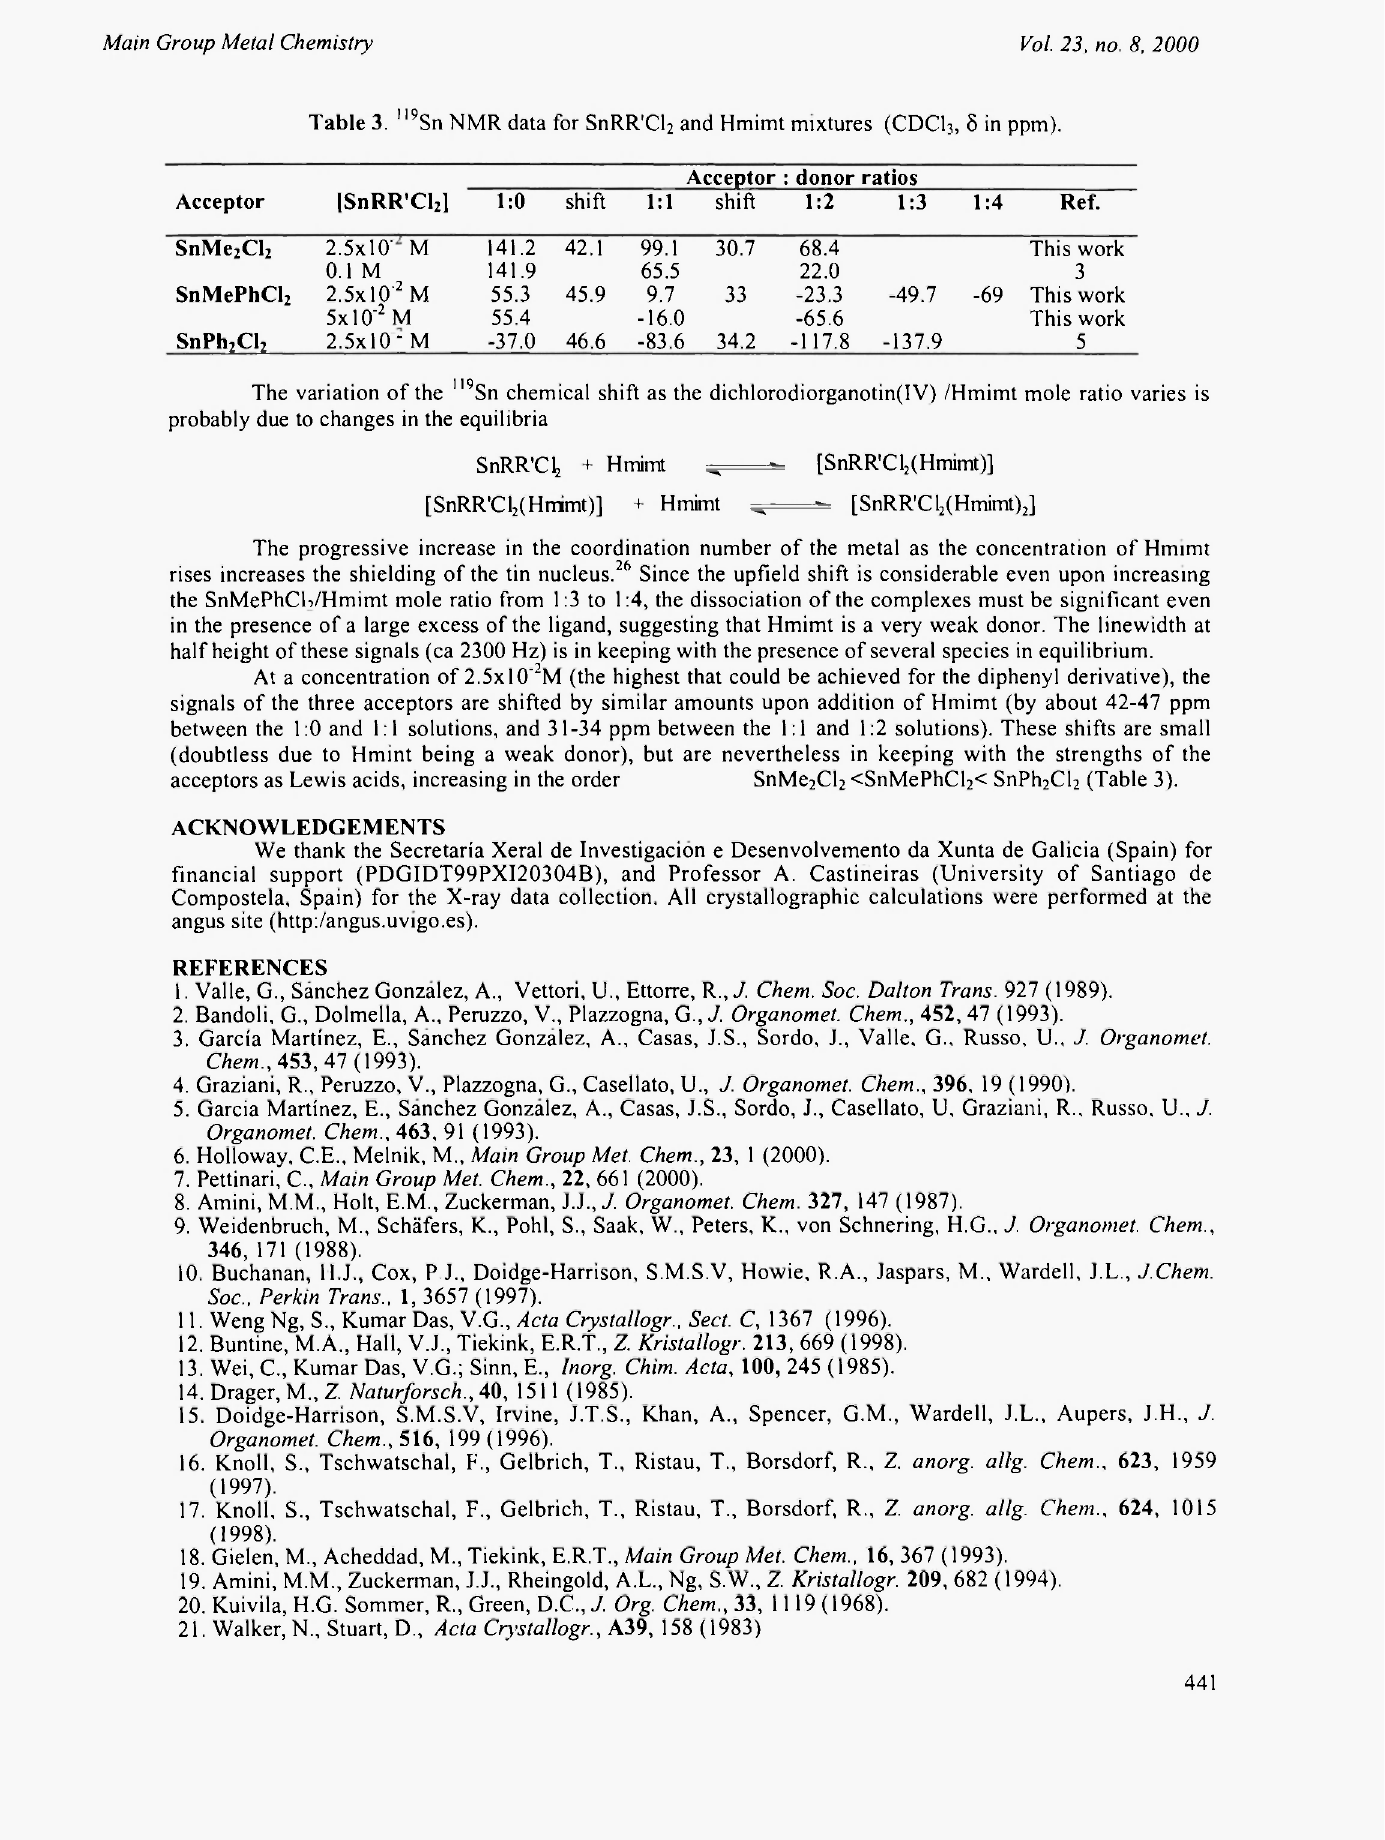
Table 3. " 9 Sn NMR data for SnRR'Clj and Hmimt mixtures (CDC1 3 , δ in